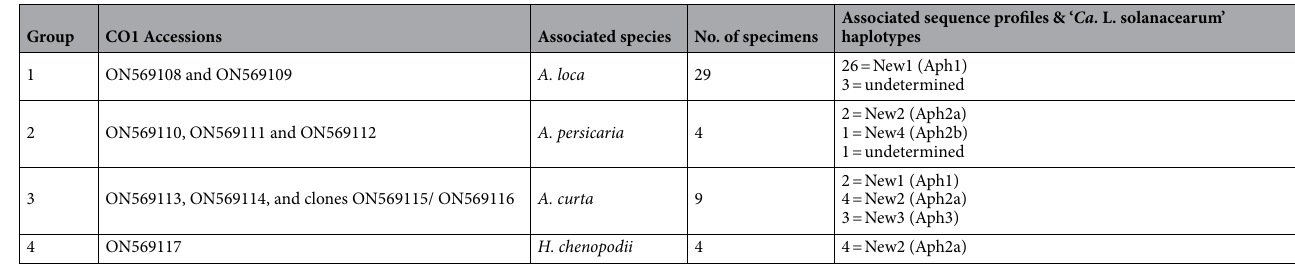
Table 4. Species of psyllids identified through molecular and morphological analysis and the associated ‘ Ca. L. solanacearum’ haplotypes identified in this study. Aphalara species identifications are with varying levels of certainty.